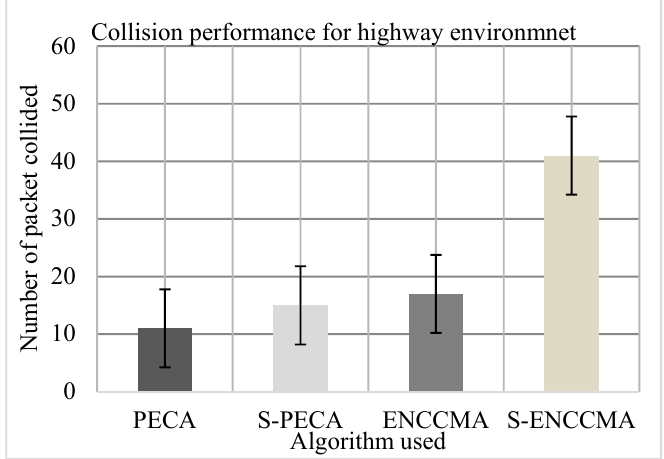
Figure 11. Collision performance for highway environment.